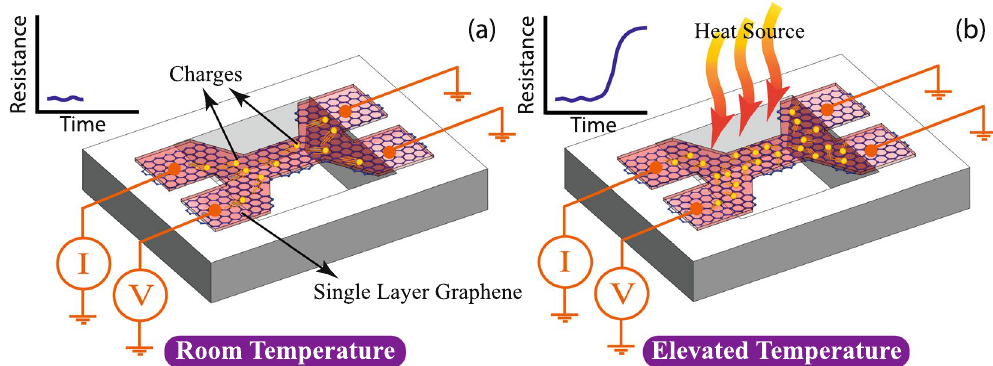
Figure 3. A schematic view of a graphene sensor. As the temperature increases from room temperature ( a ) to a high temperature ( b ), the number of electrons will be increased and their mobility will be decreased. The heat source in our measurement is the water bath as shown in Fig.